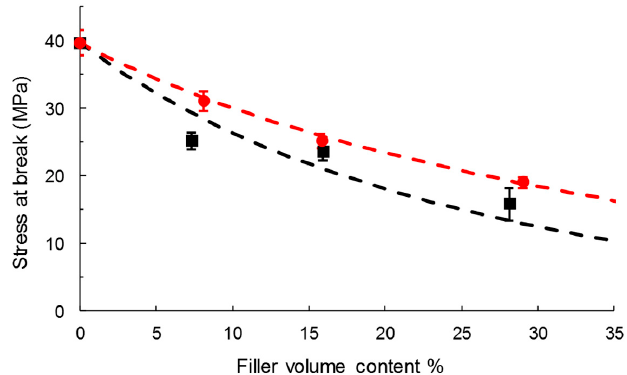
Figure 9. Pukánszky’s model applied for virgin cellulose ( - -, ■ ), B = − 0.8 and grafted cellulose ( - -, ● ), B = 0.5 based B = 0.5 based composites.